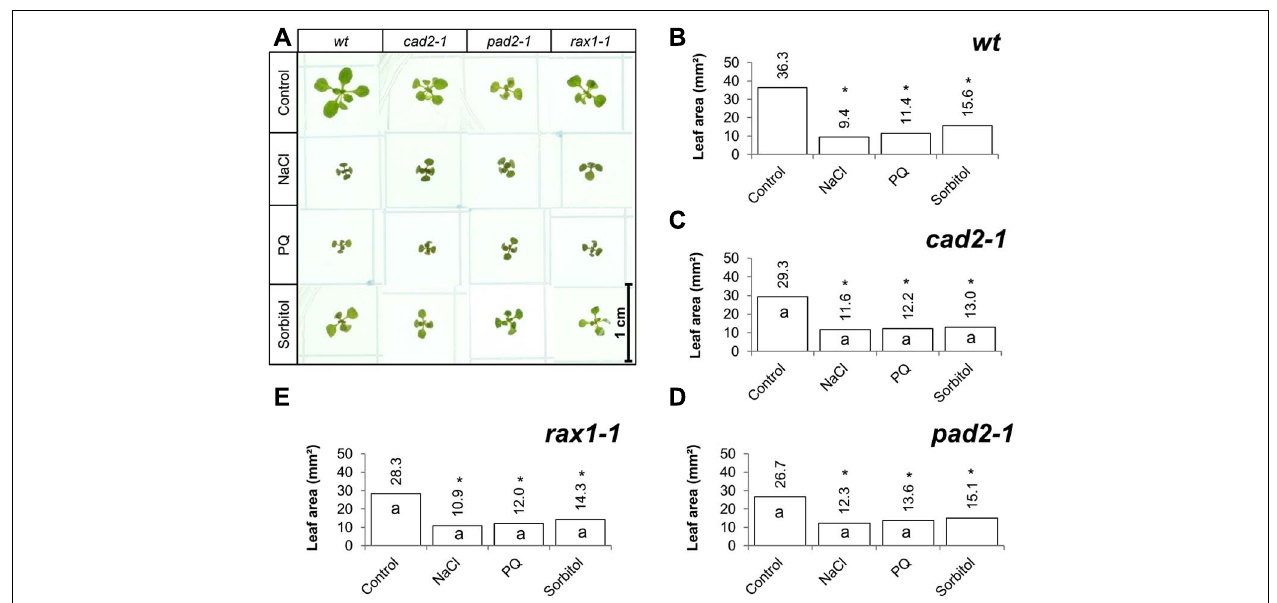
FIGURE 3 |A comparison of the effects of long-term (14 days) exposures to different abiotic stresses treatments on rosette leaf area in the rax1-1 , cad2 -1 , and pad2-1 mutants relative to wild type, Col-0 (wt). Phenotypes (A) and leaf area (B–E) of seedlings measured at 14 days either in the